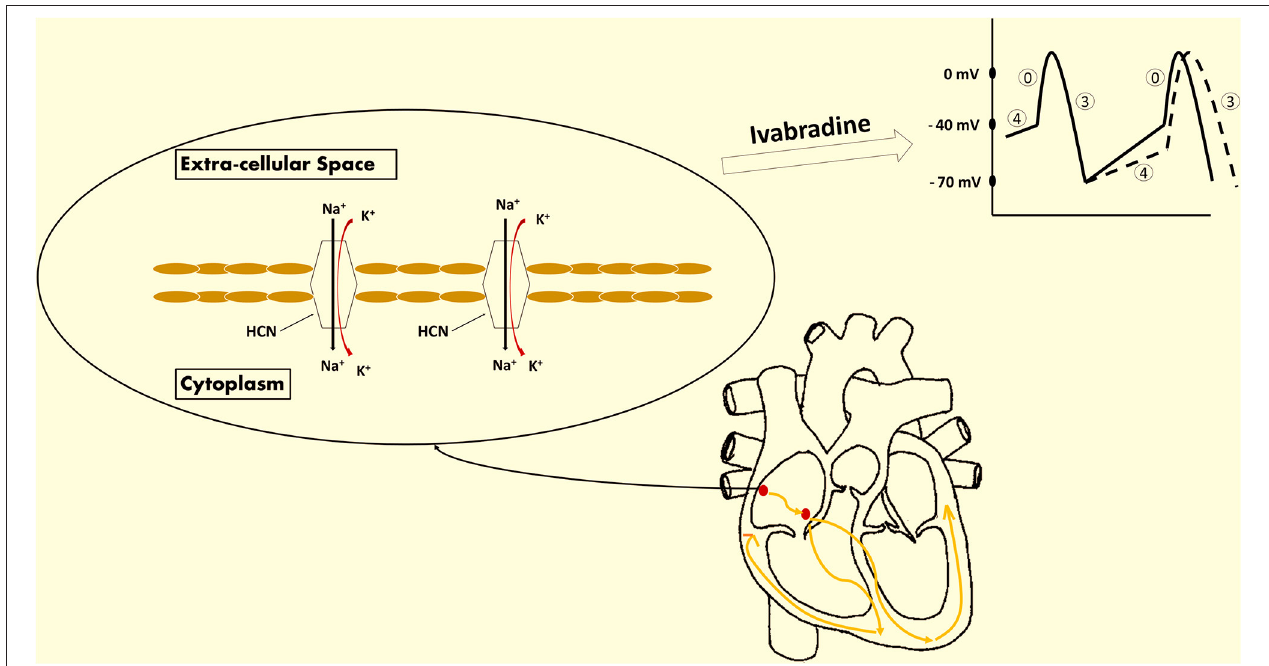
FIGURE 1 | Ivabradine’s mechanism of action. Ivabradine is a novel medication approved for the treatment of coronary artery disease (CAD) and heart failure (HF). It exhibits a negative chronotropic effect induced by the selective inhibition of the funny current channels of the sinoatrial (SA) node. The funny current is a mixed inward current of sodium and potassium that passes through the hyperpolarization-activated cyclic nucleotide-gated (HCN) channels. This current is essential for the spontaneous depolarization of the pacemaker cells of the SA node. The extent of HCN channels activation is reflected by the slope of phase 4. As a result, ivabradine exhibits its heart rate-reducing effect via the inhibition of these channels and the deceleration of phase 4 depolarization (dashed lines reflect the effect induced by ivabradine on the action potential of the SA node).